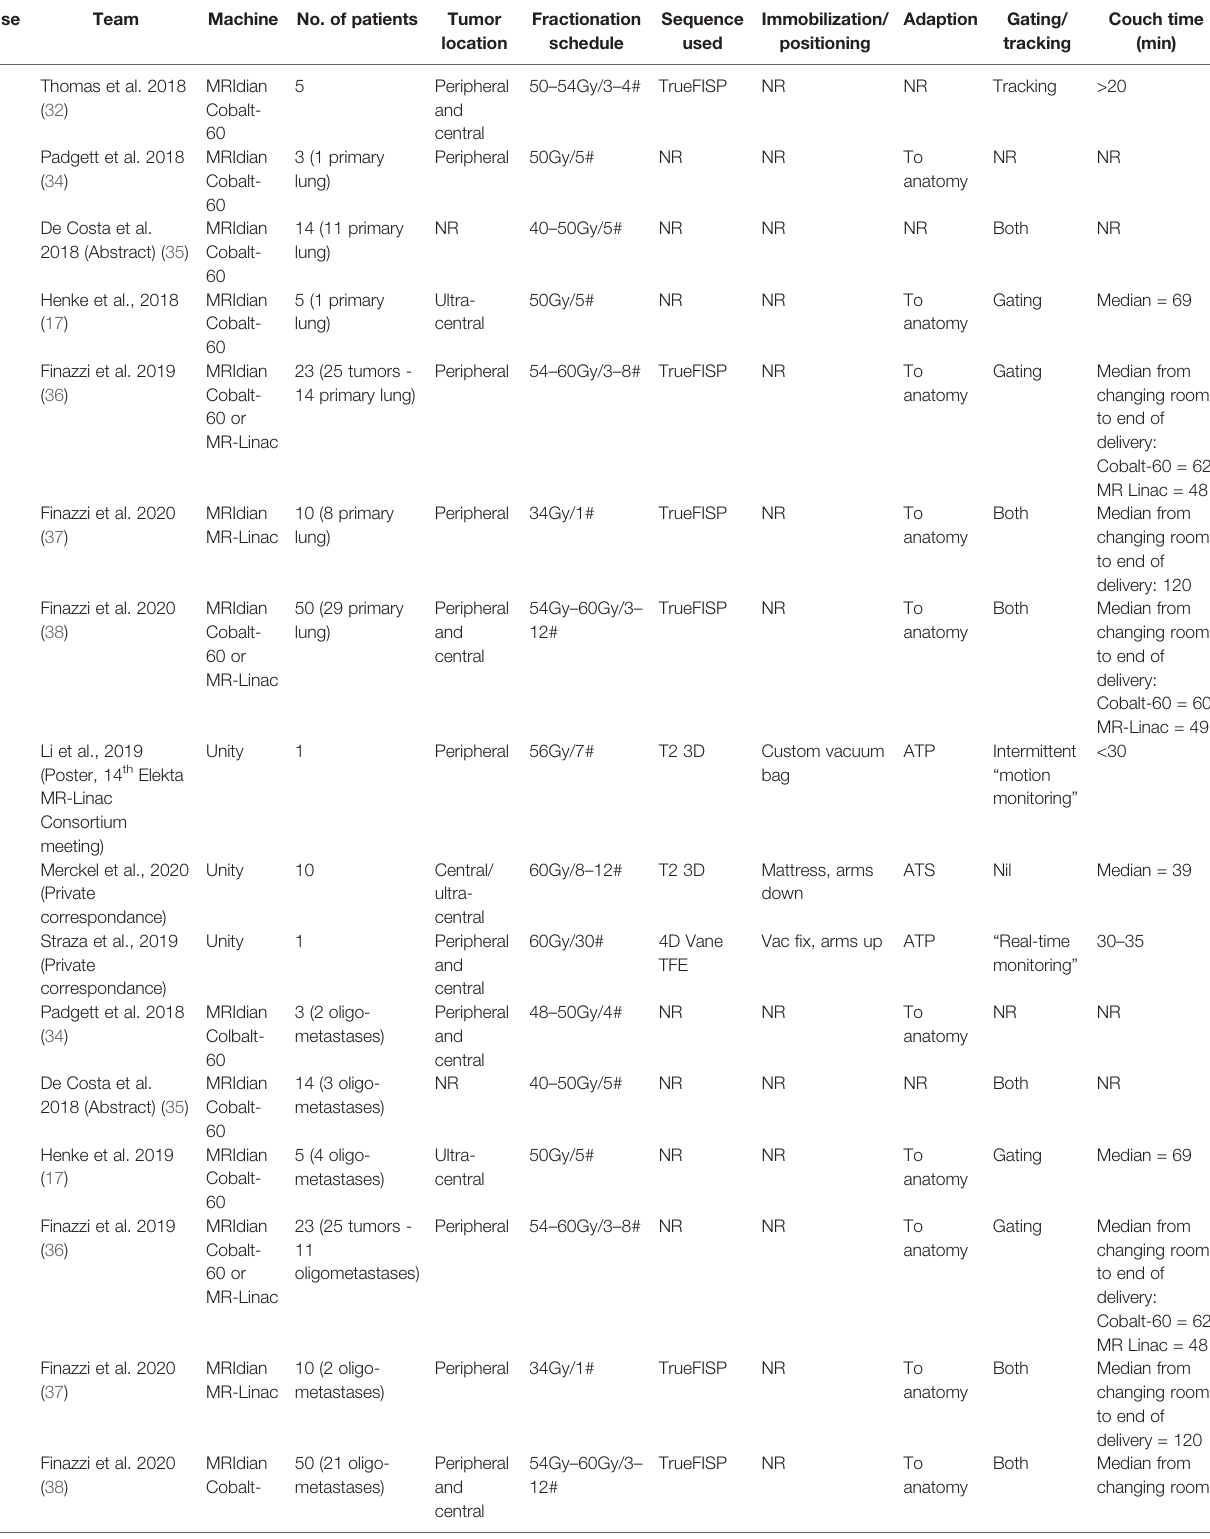
TABLE 1 | Clinical experience to date, by